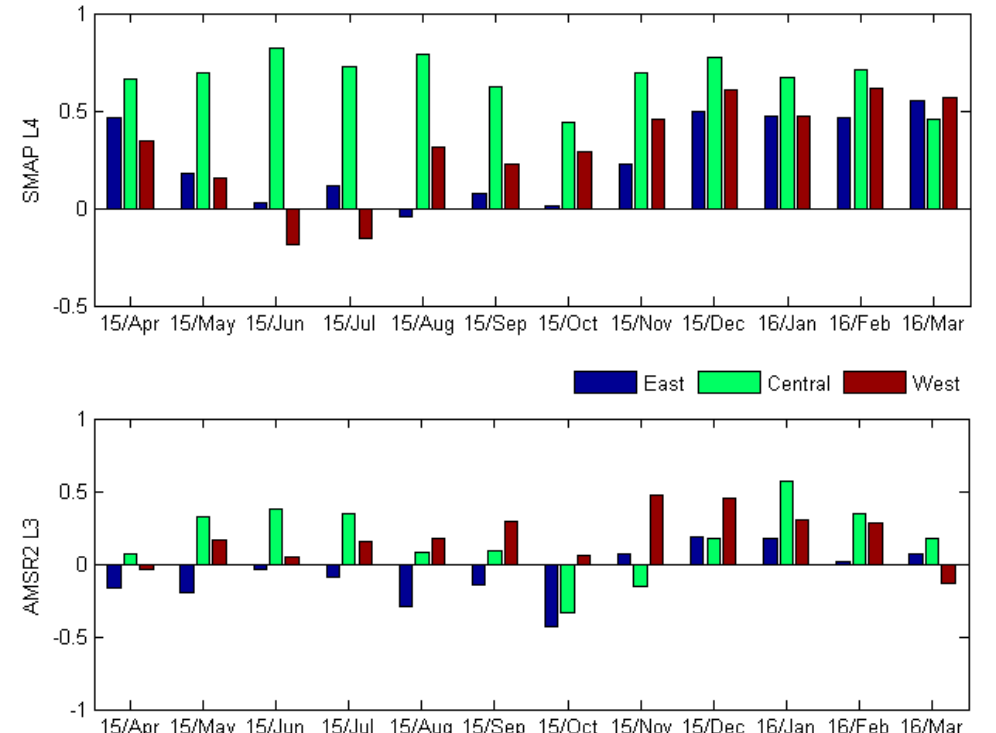
Figure 8. Temporal evolution of correlation between SMAP L4 or AMSR2 L3 monthly average data and in situ soil moisture data in west, central and east region of U.S.